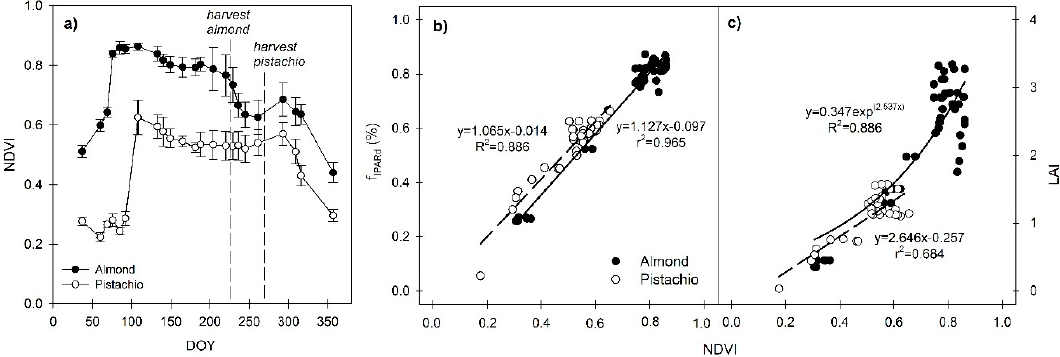
Figure 4. ( a ) Seasonal trends of the normalized difference vegetation index (NDVI), ( b ) relationships between NDVI and daily fraction of intercepted radiation (f IPAR d ), and ( c ) relationship between NDVI and leaf area index (LAI), for the almond and pistachio orchard, obtained from Landsat-8 imagery. In woody crops, potential canopy transpiration has usually been derived from the NDVI through estimates of the leaf area index (LAI) or the fraction of intercepted radiation [50,51]. Other studies have used data from eddy-covariance flux towers to relate the NDVI to in-situ measurements of K cb [52,53]. In this study, the NDVI was linearly correlated with the f IPARd over its entire range, (R 2 of 0.88 and 0.96 for pistachio and almond, respectively; Figure 4b). The little shift in this regression indicated